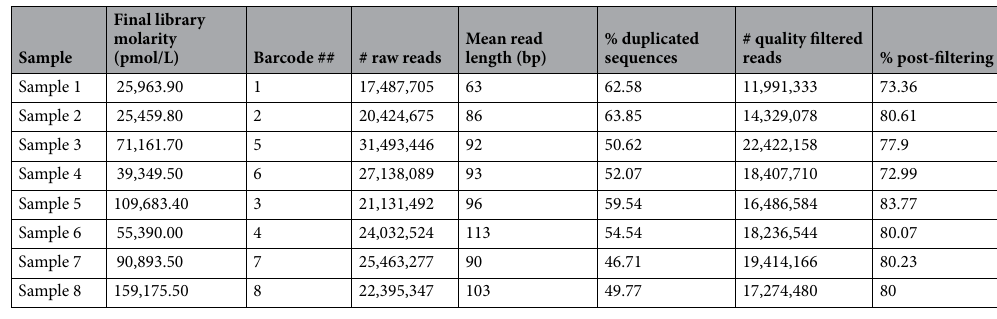
Table 2. Library and sequencing metrics for mouse RNA samples.